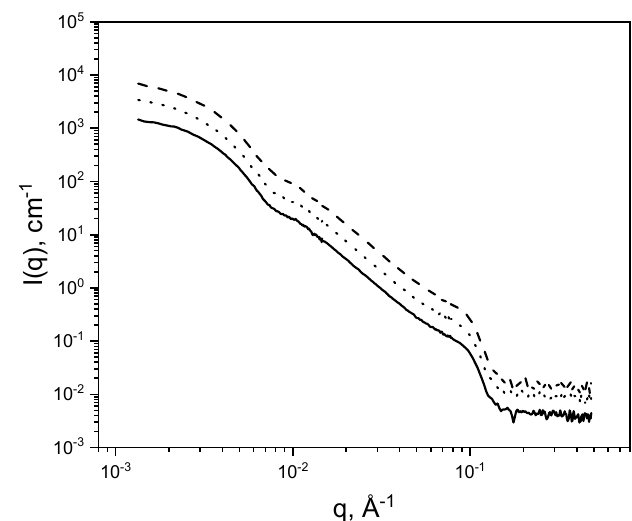
Figure 6. SANS scattering curves of DPPC (solid line), DPPC and HA with MW of 1500 kDa (dashed line) and DPPC with HA with MW of 10 kDa (dotted line) in 150 mM NaCl / D 2 O. Scattering data of DPPC with HA of 1500 kDa and DPPC with HA of 10 kDa have been shifted vertically (multiplied by 2 and 4, respectively) for better comparison.